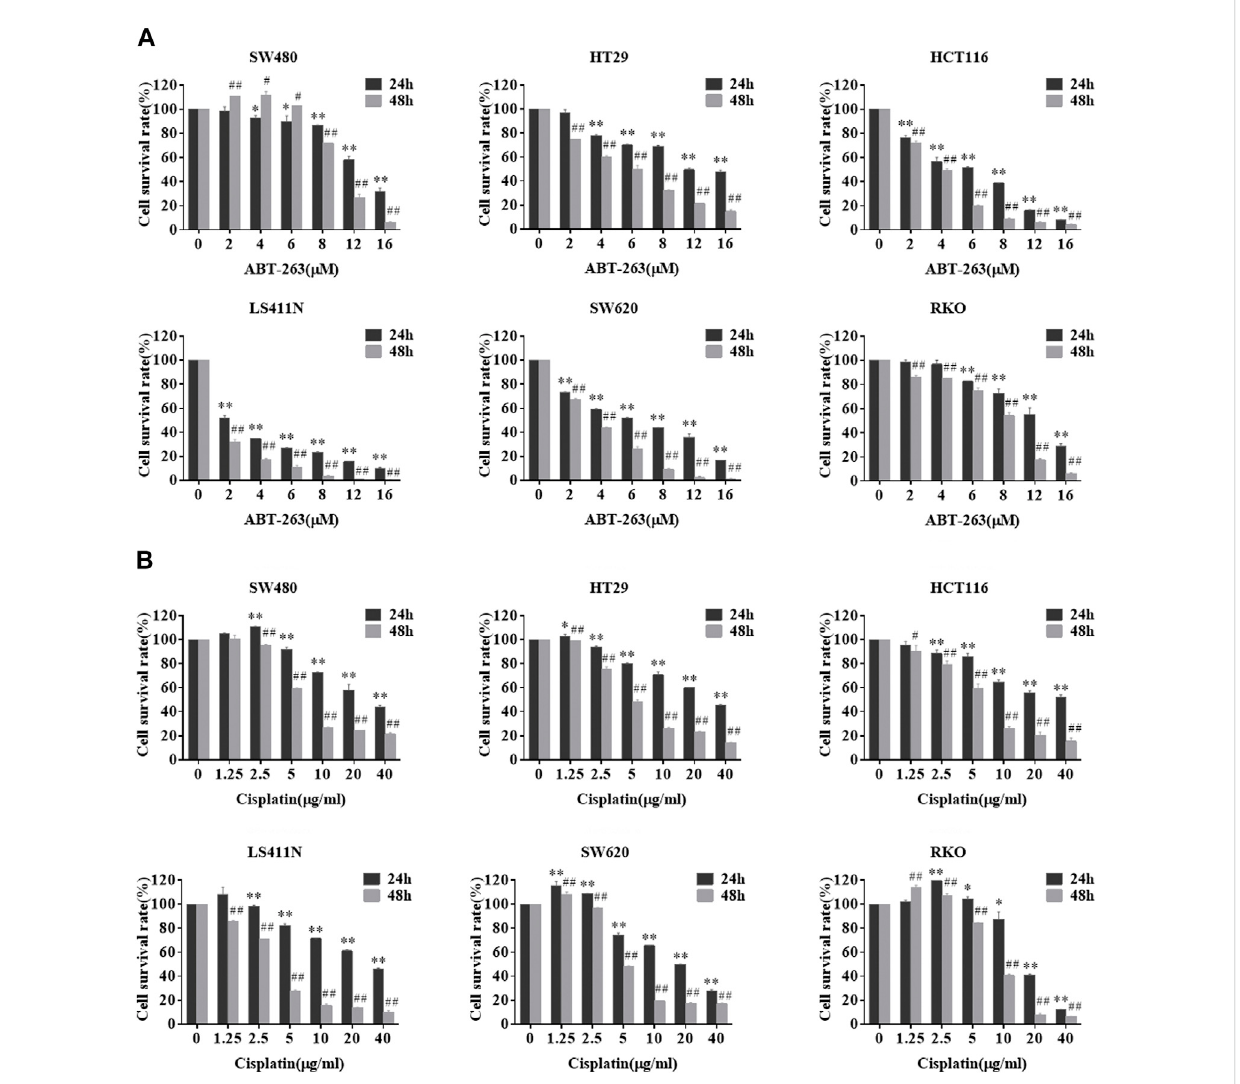
Sensitivity of different colorectal cancer cells to ABT-263 and cisplatin. After treating CRC cell lines with different concentrations of ABT-263 (A) or cisplatin (B) for 24 or 48 h, MTT assay was used to determine the cell viability to con fi rm the cytotoxicity of the two drugs. Data are presented as mean ± SD for three separate experiments. *, # p < 0.05; **, ## p < 0.01 vs.